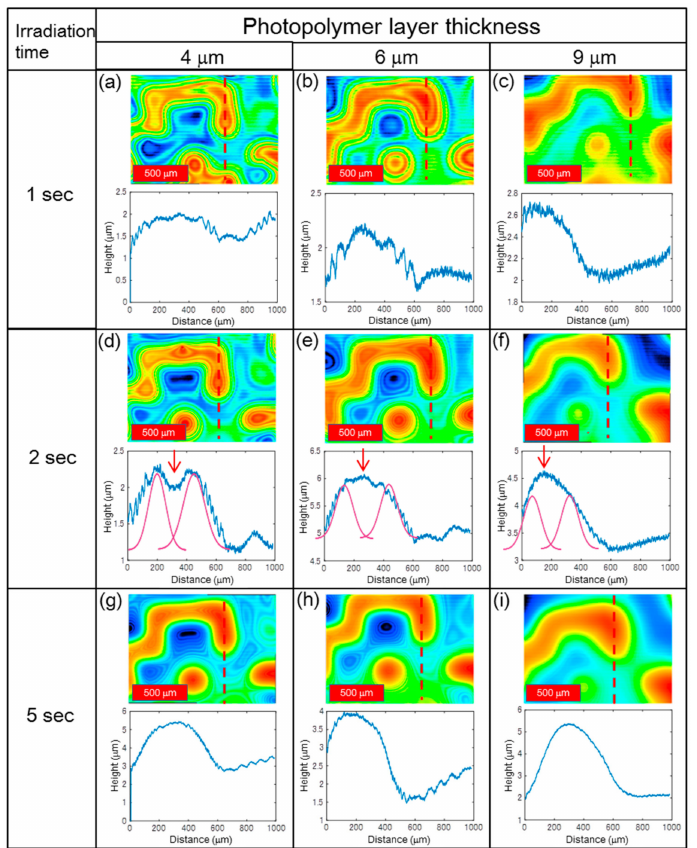
Figure 8. Two-dimensional surface volume changes and the cross-sectional distributions for continuous Gaussian-like random phase masks under photopolymerization depending on both the photopolymer layer thickness and UV irradiation